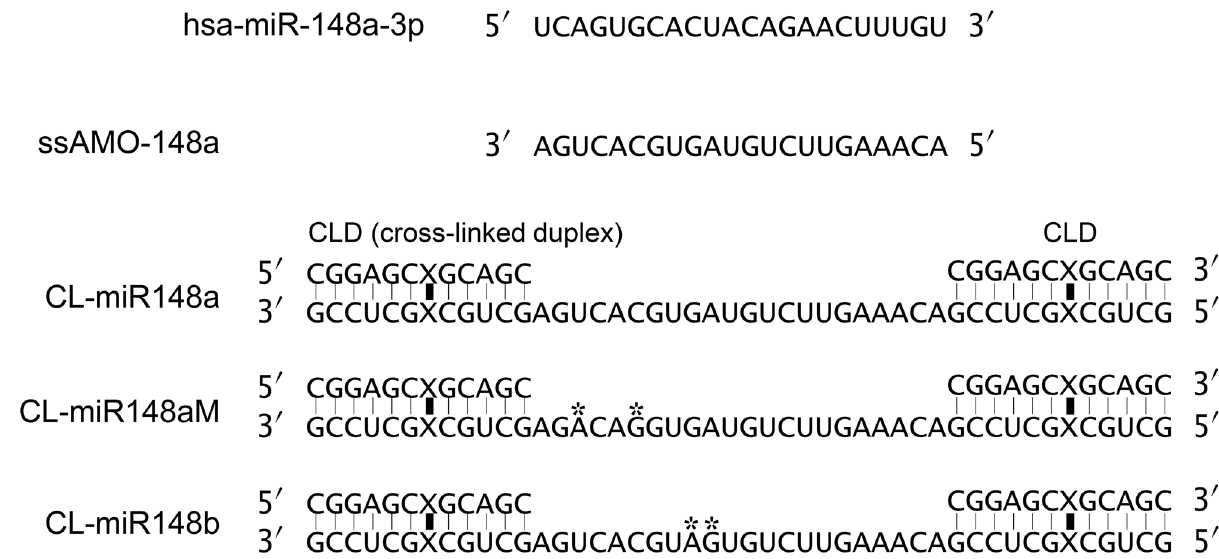
Figure 1. Sequences of miR-148a, ssAMO-148a, and CL-AMOs. CL-miR148a holds CLDs at both 5 ′ - and 3 ′ -termini of the antisense sequence complementary to miR-148a. CL-miR148aM is similar to the antisense, except that it contains two mismatched bases identified by asterisks. CL-miR148b is designed to hybridize with miR-148b. The vertical bold lines and Xs indicate cross-linker and cross-linked sites,